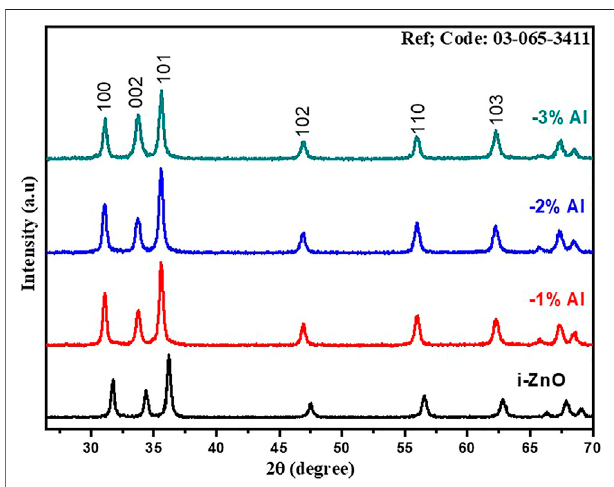
FIGURE 1 | XRD spectra of ZnO and Al doped ZnO nanomaterials.